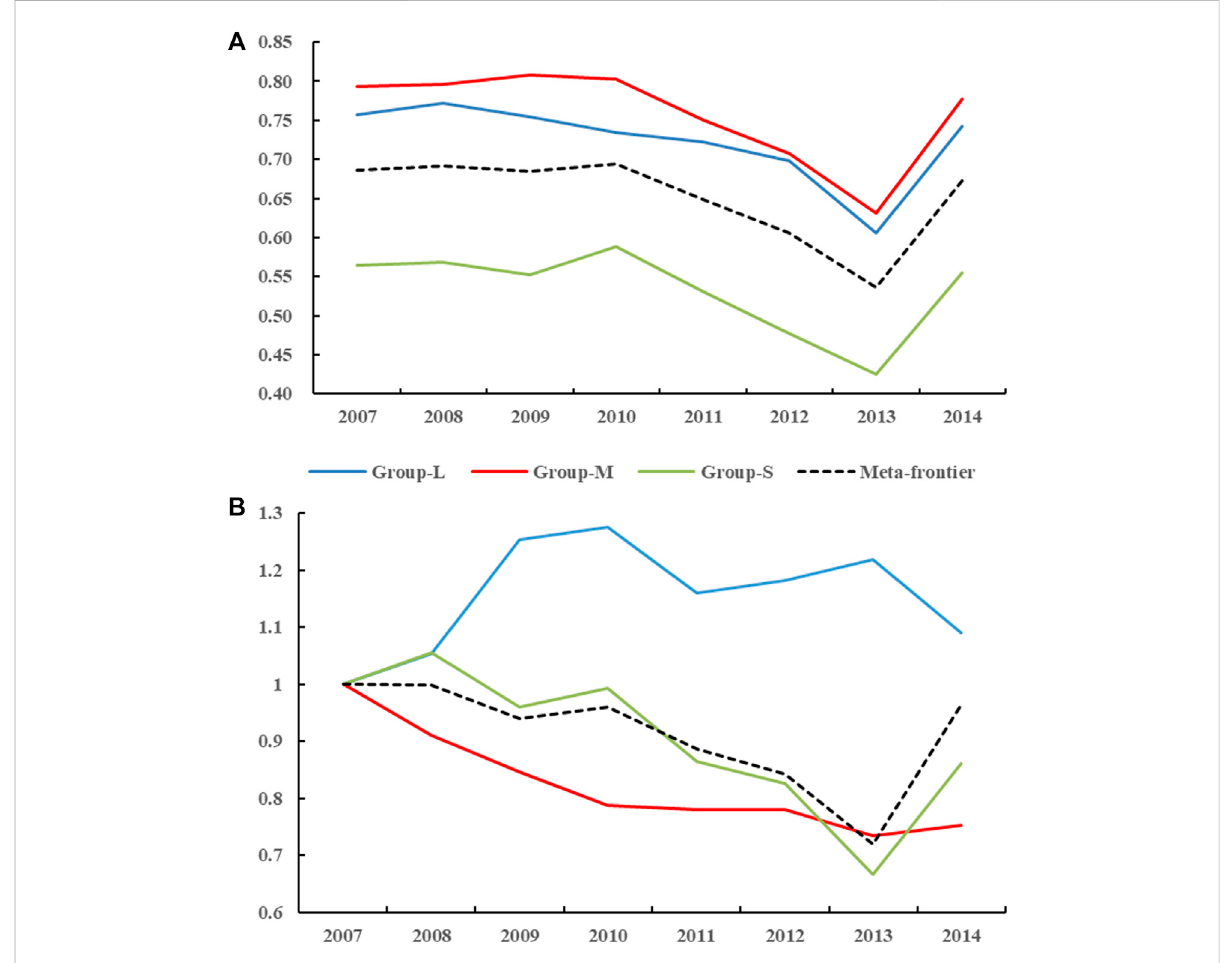
FIGURE 3 Time series changes of energy ef fi ciency (A) and energy technology (B) of different groups in 2007 – 2014.